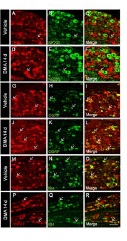
Figure 6. Double staining of TRPV1 with other neuronal markers in DRG. A–R , representative staining of TRPV1 (red) with NF200 (green; A–F ), with CGRP ( G–L ), with IB4 ( M–R ) in vehicle-treated and DMA 14 d rats. Arrows indicate double-labeled neurons. Scale bar =100 m m.